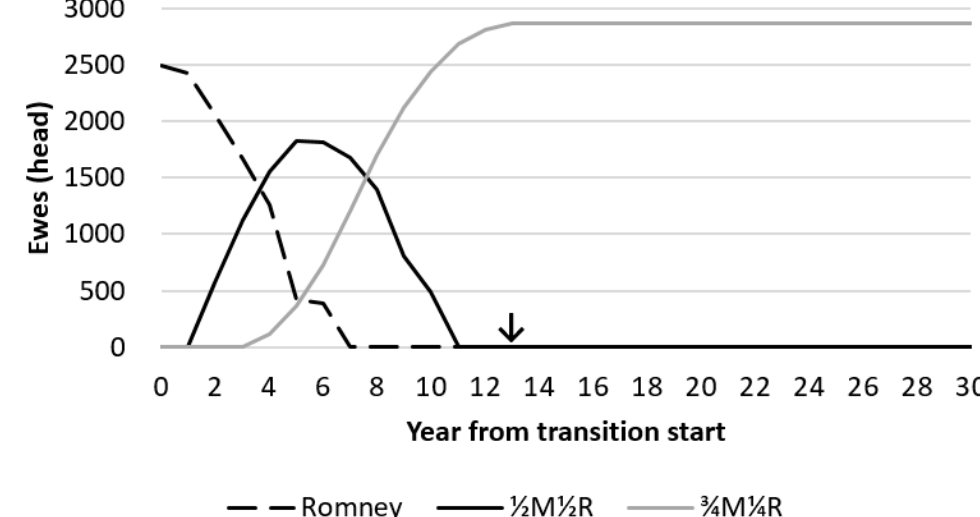
Figure 3. Numbers of Romney, 1 / 2 Merino 1 / 2 Romney, and 3 / 4 Merino 1 / 4 Romney ewes during a grading up transition. ↓ indicates where the 3 / 4 Merino 1 / 4 Romney flock has reached the same annual feed demand as the base Romney flock.